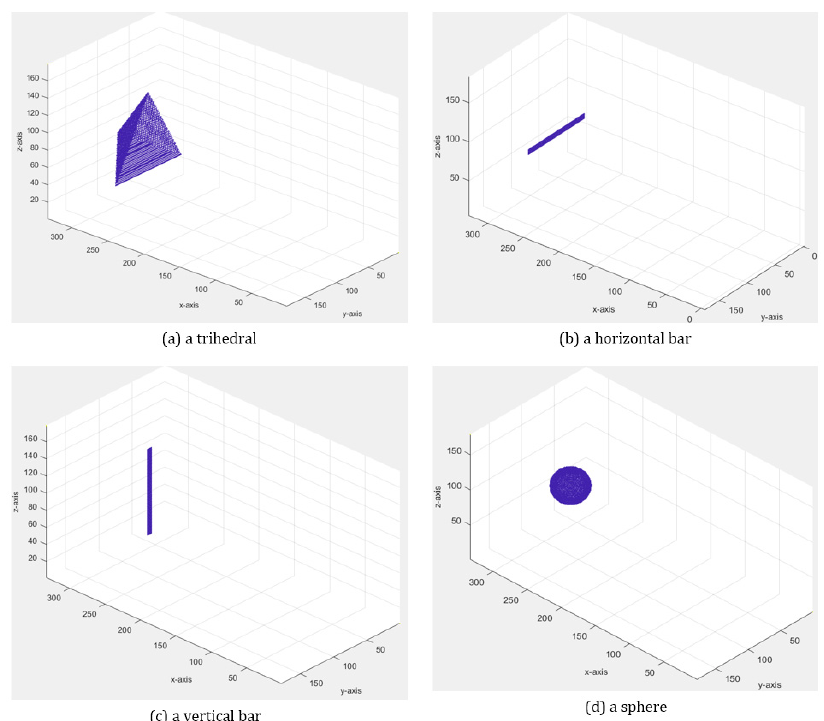
Figure 6. The four target types synthesized by the tool. In this figure, the elevation angle is 0° and aspect angle is also 0°.